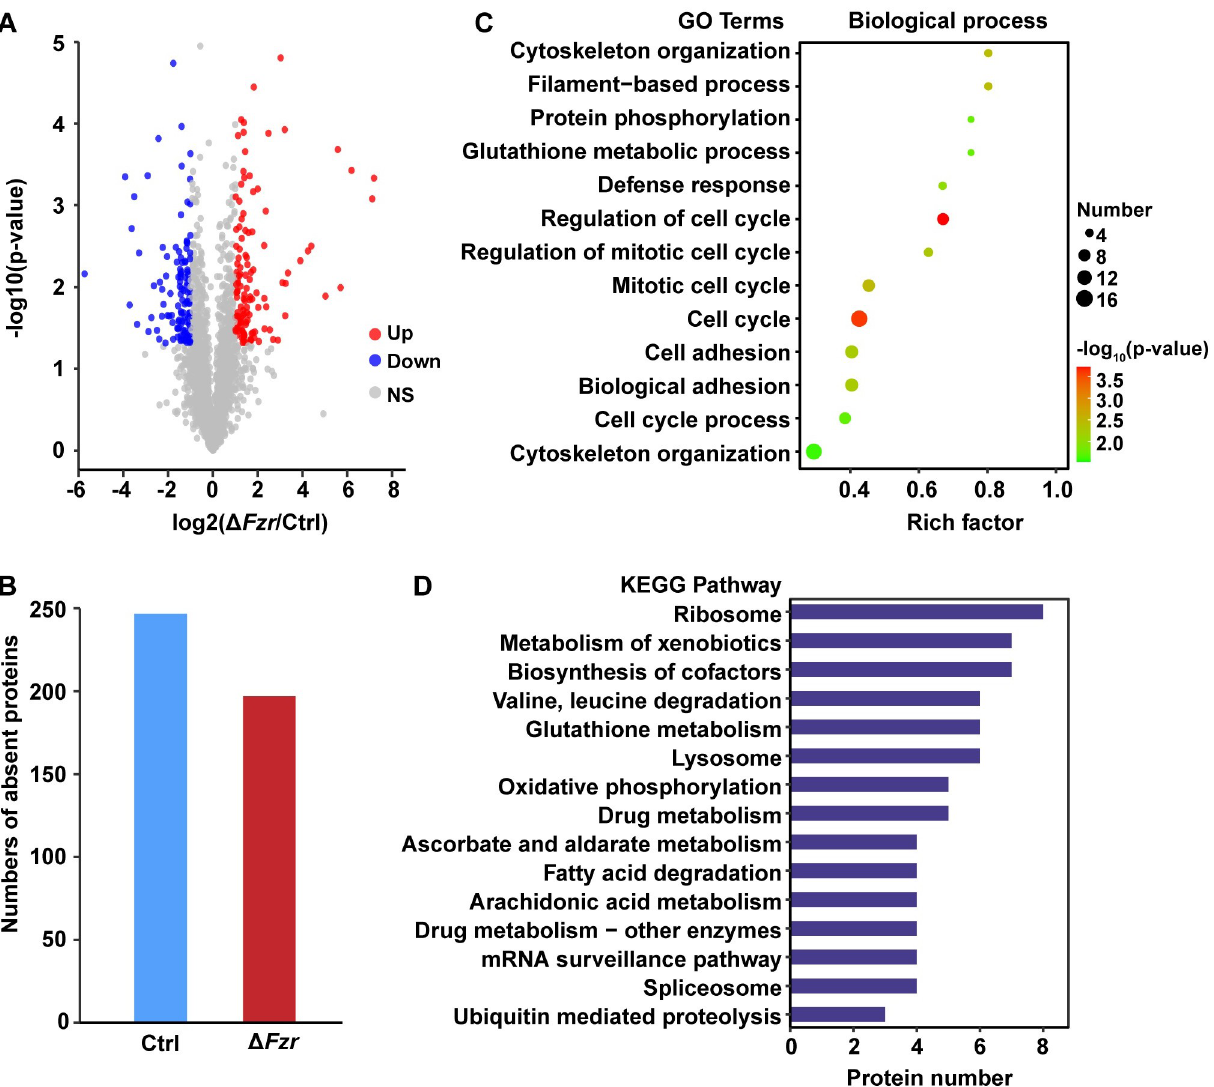
Fig 4. Label-free quantitative proteomic analysis of Fzr mutation-caused proteome change in the PSG. ( A ) The volcano plots of the quantified proteins. Red points represented upregulated proteins and blue points represented downregulated proteins. DEPs were identified with a regular criterion of P value < 0.05 and log2 fold change (log2FC) � 1.0. ( B ) DEPs were present or absent following Fzr mutation in the PSG. ( C ) GO annotation of DEPs in biological process class. Size of dots represented numbers of enriched proteins; Color of dots represented the GO cluster with a highlighted representative term. ( D ) The enriched KEGG